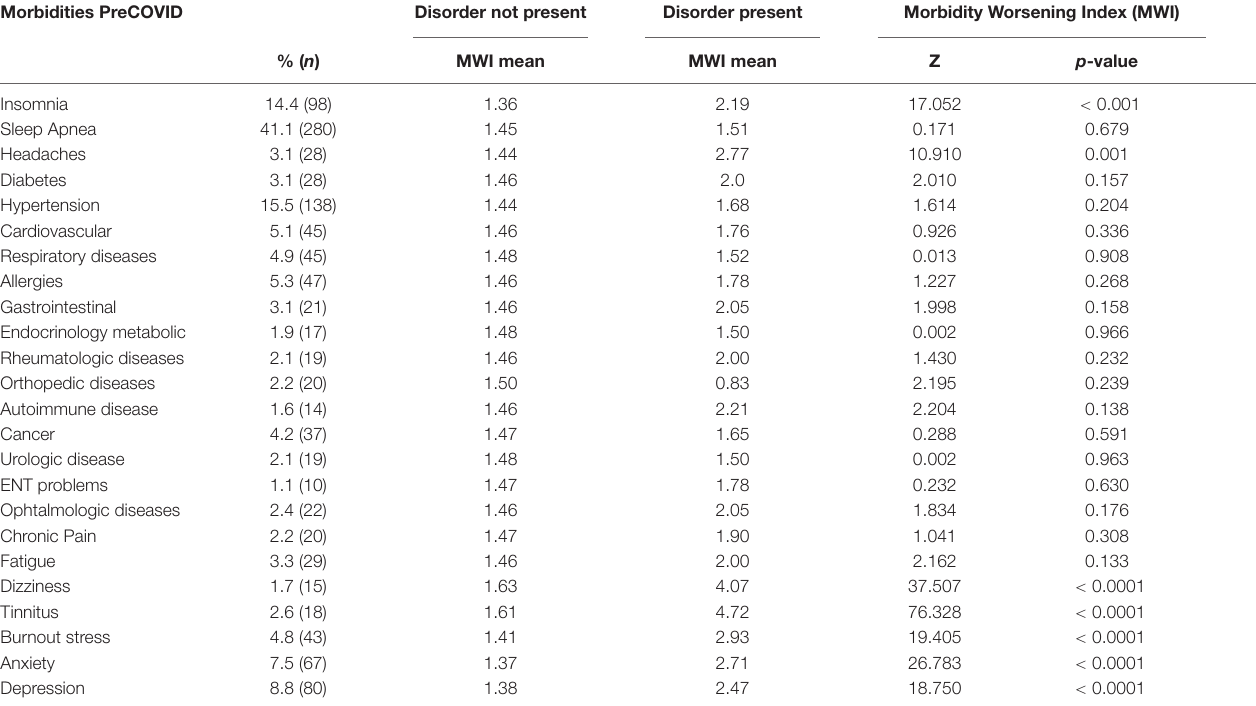
TABLE 8 | Morbidities Pre COVID and Morbidities worsening in the elderly. Morbidities PreCOVID Disorder not present Disorder